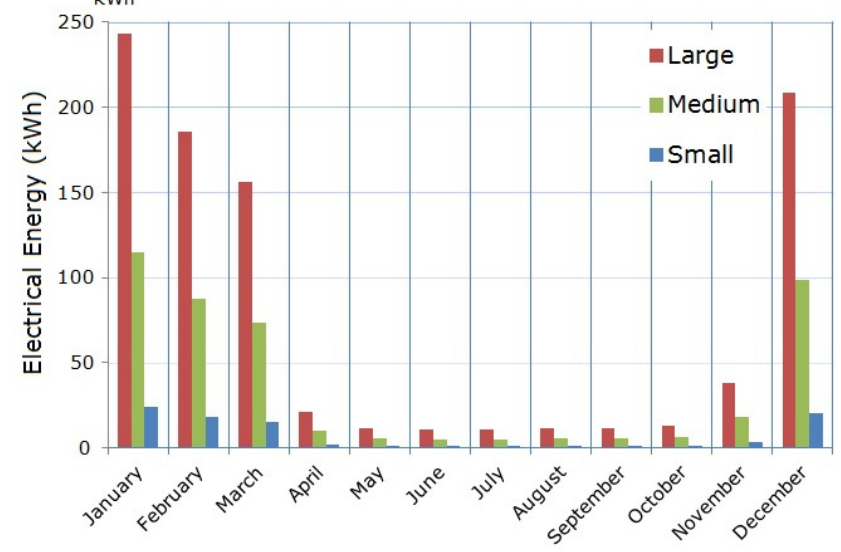
Figure 1. Average electrical energy consumption of olive mills depending on their